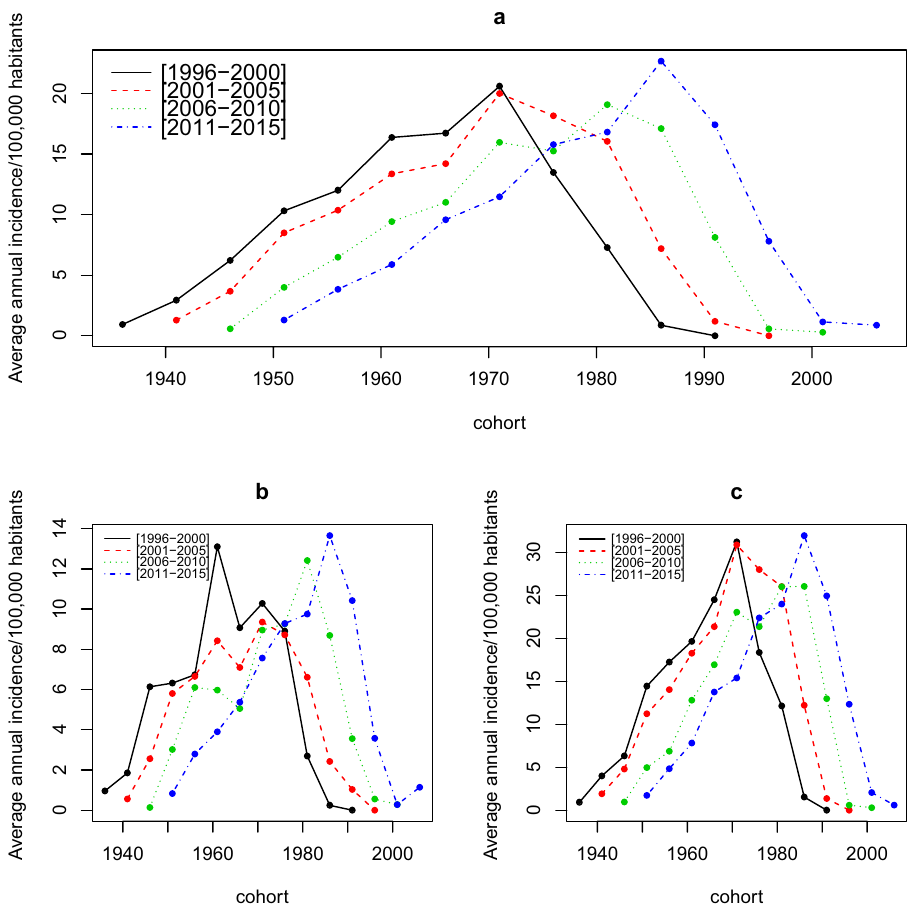
Figure 3. Time series of the change in annual average incidence for multiple sclerosis per 100,000 population during successive cohorts by period, all sexes combined ( a ), for men ( b ) and women ( c